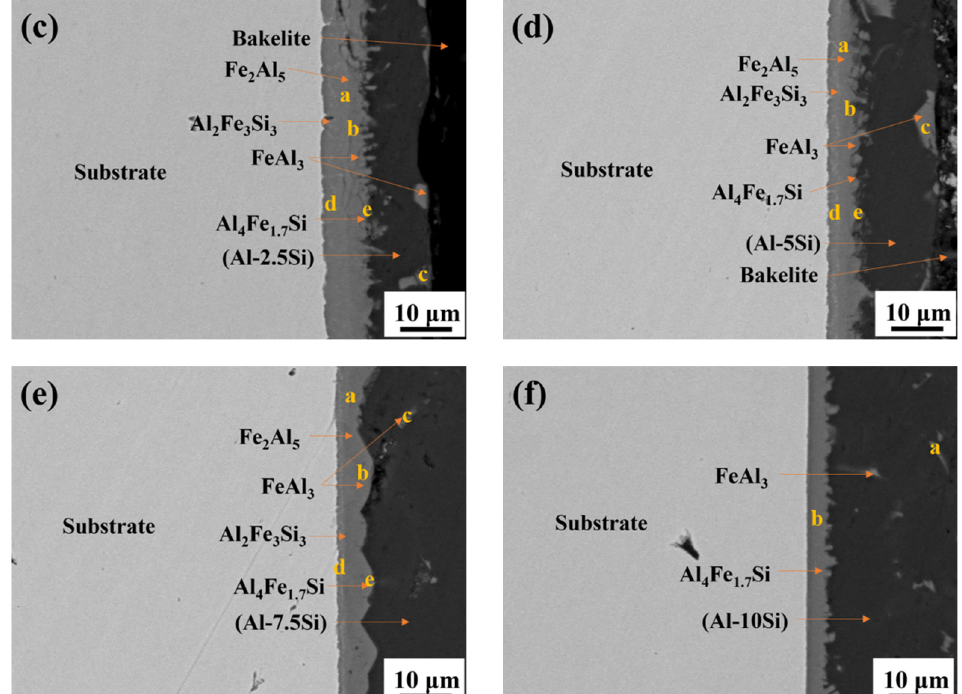
Figure 3. Cross-sectional micrographs of coatings of Q345 steel hot-dipped in baths with different Si addition at 750 °C for 30 s. ( a ) 0.5Si, ( b ) 1Si, ( c ) 2.5Si, ( d ) 5Si, ( e ) 7.5Si, and ( f ) 10Si. Table 3. Phase analysis by EDS in Figure 3